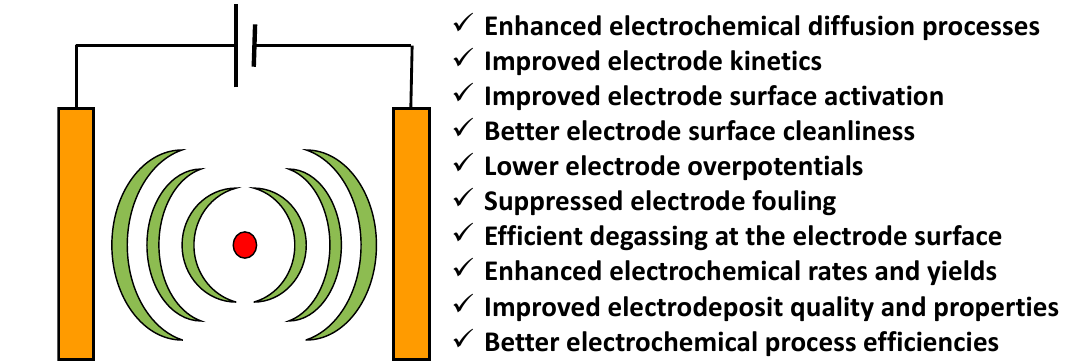
Figure 6. Short summary of the benefits of ultrasound in electrochemistry [19].